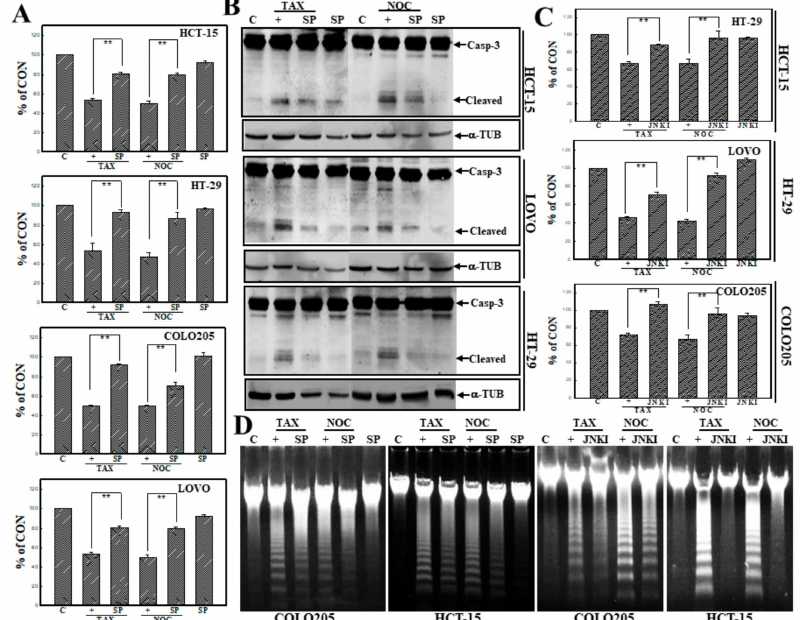
Figure 3. c-Jun N-terminal kinase (JNK) activation participated in TAX- and NOC-induced apoptosis of human CRC cells. ( A ) The JNK inhibitor SP600125 (SP) protected cells from TAX- and NOC-induced cytotoxicity in human CRC cells. Human CRC cells were treated with SP (10 µ M) for 30 min followed by TAX or NOC (10 µ M) treatment for 24 h. The viability of cells under di ff erent treatments was examined by an MTT assay, and results are expressed as a percentage of the control (% of CON). ( B ) SP inhibition of cleavage of Casp-3 protein in human CRC cells. As described in ( A ), expressions of the Casp-3 and α -TUB proteins were examined by Western blotting using specific antibodies. ( C ) Addition of JNK inhibitor V (JNKI) reversed the cytotoxicity of TAX and NOC in HCT-15, HT-29, and COLO205 cells. Cells were treated with JNKI (10 µ M) for 30 min followed by TAX and NOC (10 µ M) treatment for 24 h. The viability of the cells was examined by an MTT assay. ( D ) SP and JNKI inhibited TAX- and NOC-induced DNA ladders in human CRC cells. As described above, DNA integrity was examined by agarose electrophoresis. Data from three independent experiments were obtained and are displayed as the mean ± SD. ** p < 0.01 denotes a significant di ff erence between indicated